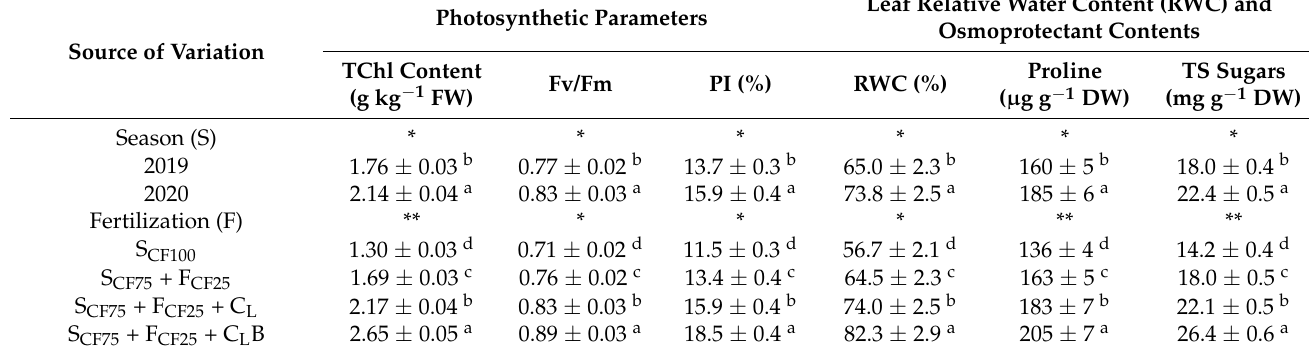
Table 6. Response of photosynthetic parameters, relative water content, and osmoprotectant contents of Phaseolus vulgaris plants to growing season (2019 and 2020) and different fertilization strategies applied to virgin sandy